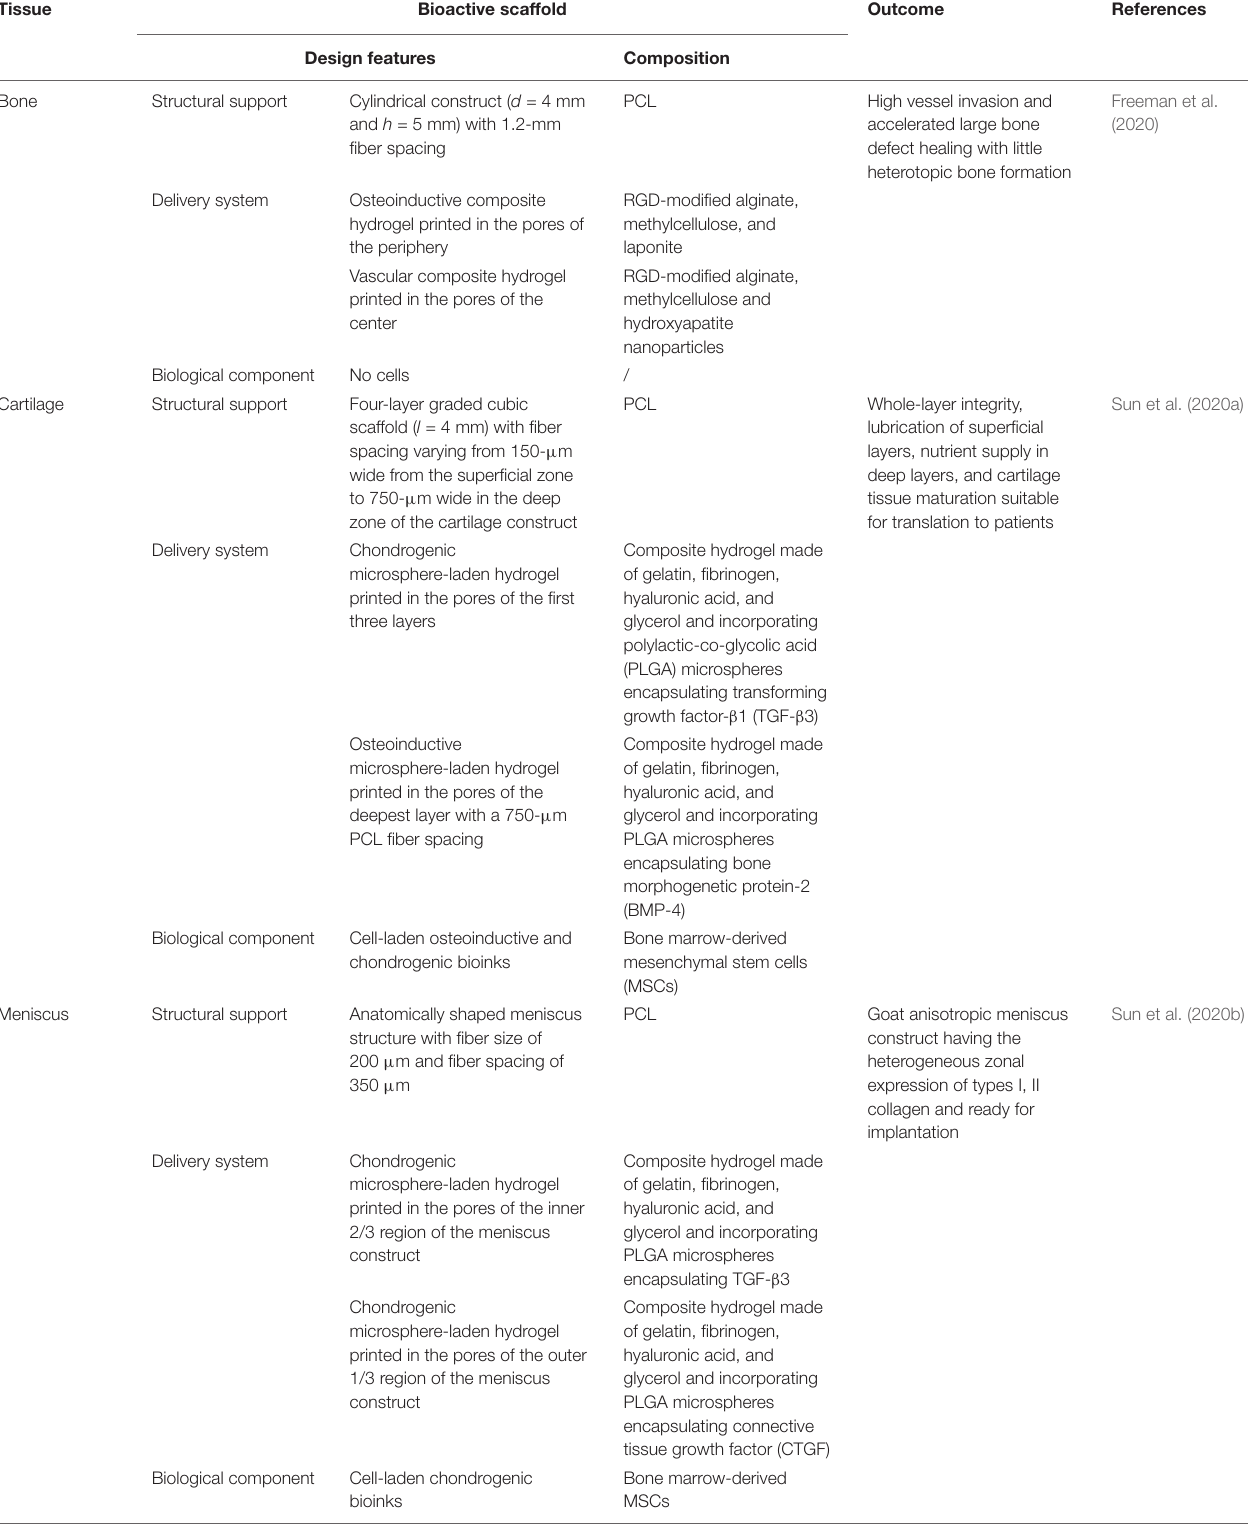
TABLE 1 | Examples about the use of the bioprinting technique to fabricate complex drug delivery scaffolding systems for the regeneration of musculoskeletal tissues. Tissue Bioactive